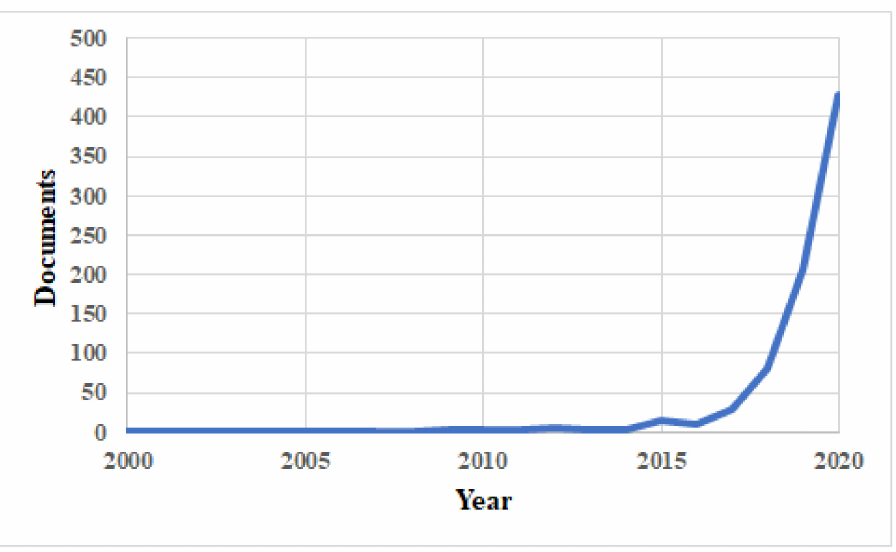
Figure 1. Scopus bibliographic histogram relating to machine learning/deep learning and chest X-ray showing exponential growth in published works over the past